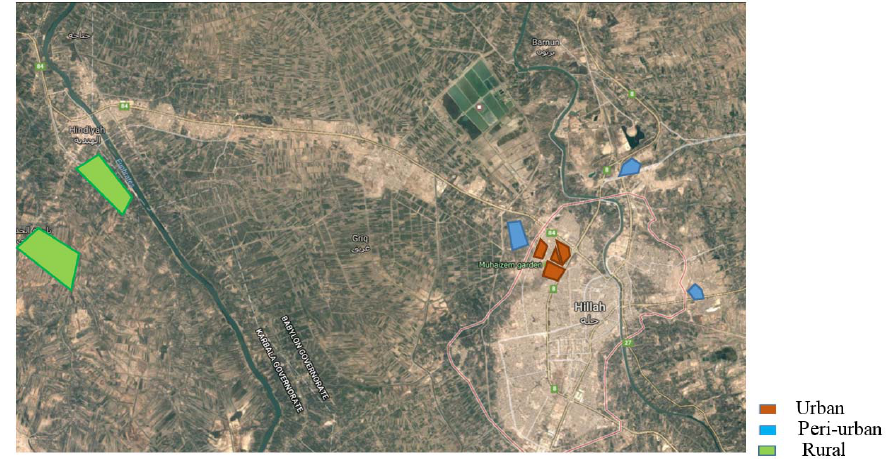
Figure 2. Study site locations, Al-Hillah, Iraq (Google Maps, 2016).